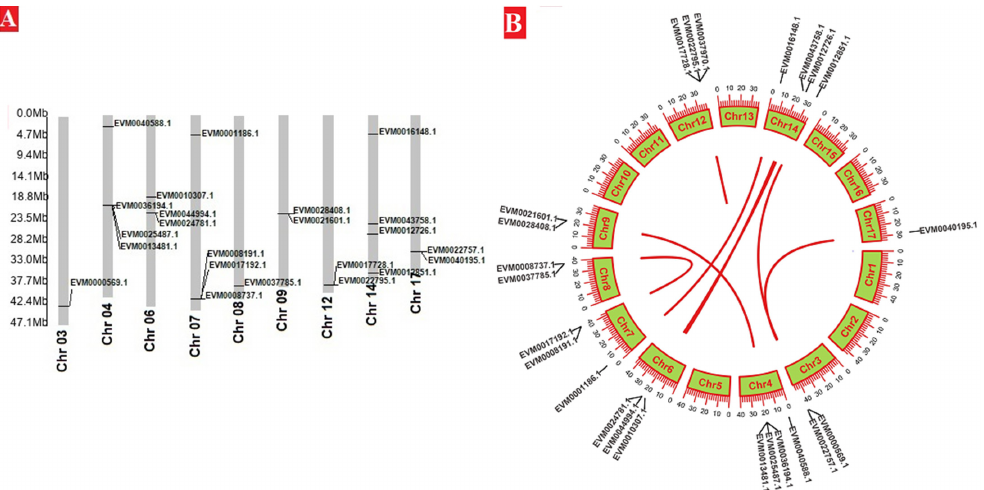
Figure 6. ( A ) Chromosomal mapping of EjALMT genes. ( B ) Chromosomal distribution and gene duplication of EjALMTs . Gene IDs are labeled as per chromosomal location basis. Whole-genome duplication (WGD)/segmental-duplication genes are denoted as red lines.